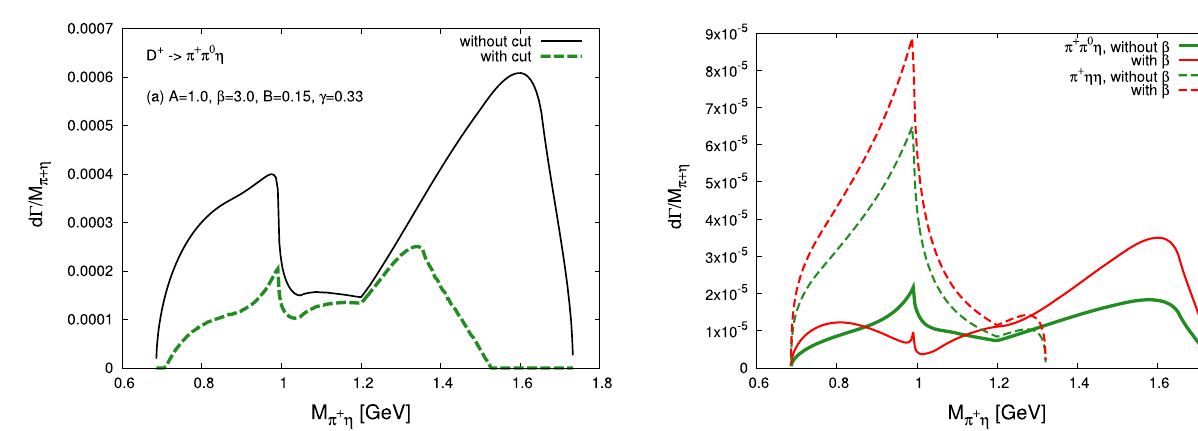
Fig. 13 the mass distributions corresponding to Fig. 10